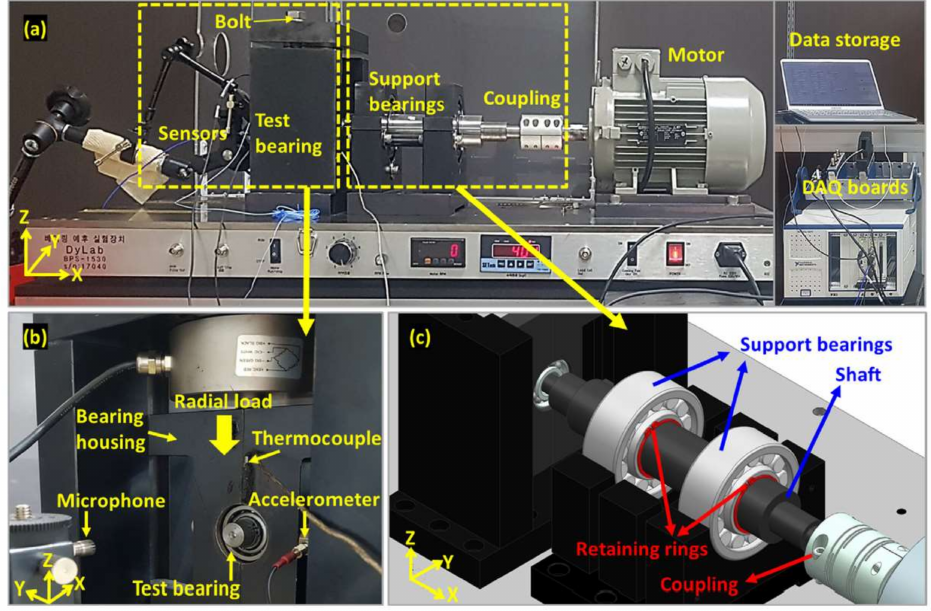
Figure 6. The bearing testbed ( a ) Front view of the bearing test rig ( b ) Close up view of test bearing and sensors ( c ) Close up view of support bearings and